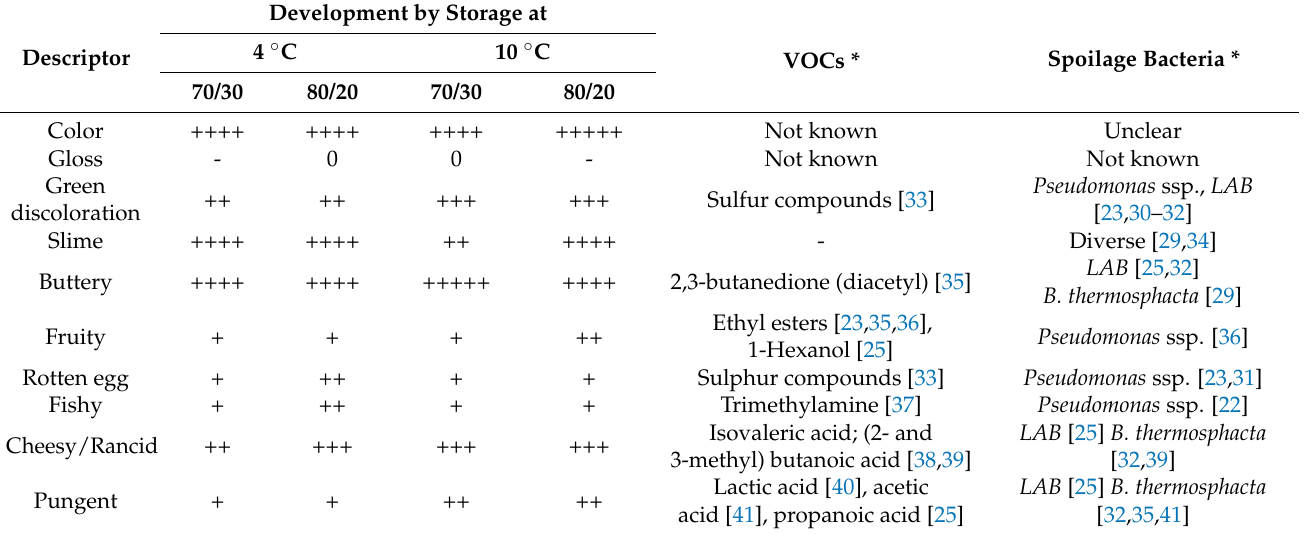
Table 4. Sensory evaluation of the visual and olfactory descriptors under different storage conditions from day 0 to the last day of sensory evaluation (4 ◦ C: Day 14, 10 ◦ C: Day 8). Each + stands for